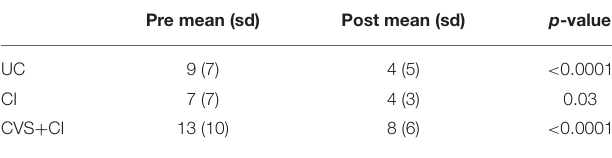
TABLE 3 | Norepinephrine dose around nimodipine switch [mg/day].